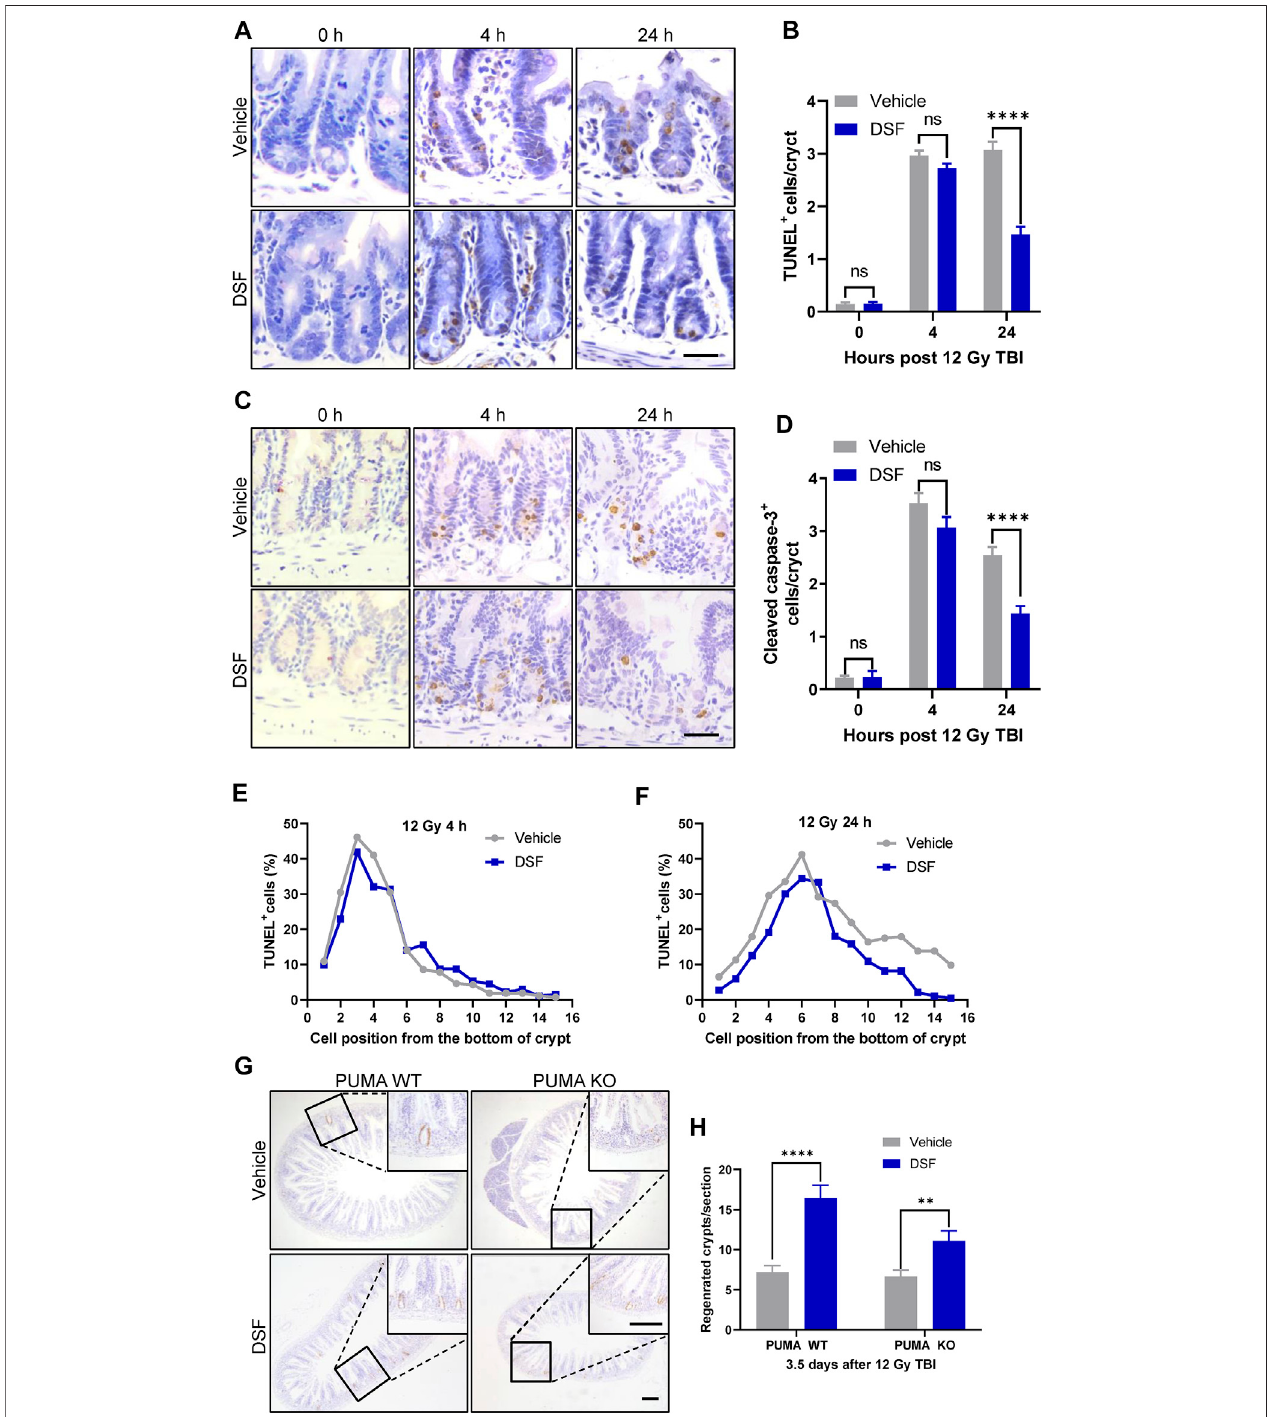
FIGURE 4 | DSF pretreatment has no effect on early phase apoptosis but mitigates the delayed apoptosis of crypt cells after irradiation. Mice were intraperitoneal injected with 100 mg/kg DSF or vehicle 1 h prior to 12 Gy irradiation. (A) Representative images of TUNEL staining. Scale bar = 20 μ m. (B) Quantitative analysis of TUNEL-positive cells in (A) . (C) Representative images of cleaved caspase 3 IHC. Scale bar = 20 μ m. (D) Quantitative analysis of cleaved caspase3-positive cells in (C) . (E) FractionsofTUNEL-positivecryptcellsat4 hbasedoncellpositionsin (A) . (F) FractionsofTUNEL-positivecryptcellsat 24 hbasedon cellpositionsin (A) . (G) Representative images of BrdU IHC in small intestine of PUMA WT and PUMA KO mice 3.5 days after 12Gy TBI. Scale bar = 200 μ m (top) and 200 μ m (bottom). (H) Quantitative analysis ofregenerated cryptsper circumference in (G) .Values are means ±SEM; n=3-4 mice ineach group. ** p < 0.05and **** p < 0.0001,vehicleversus DSF treatment, by unpaired, two-tailed Student ’ s